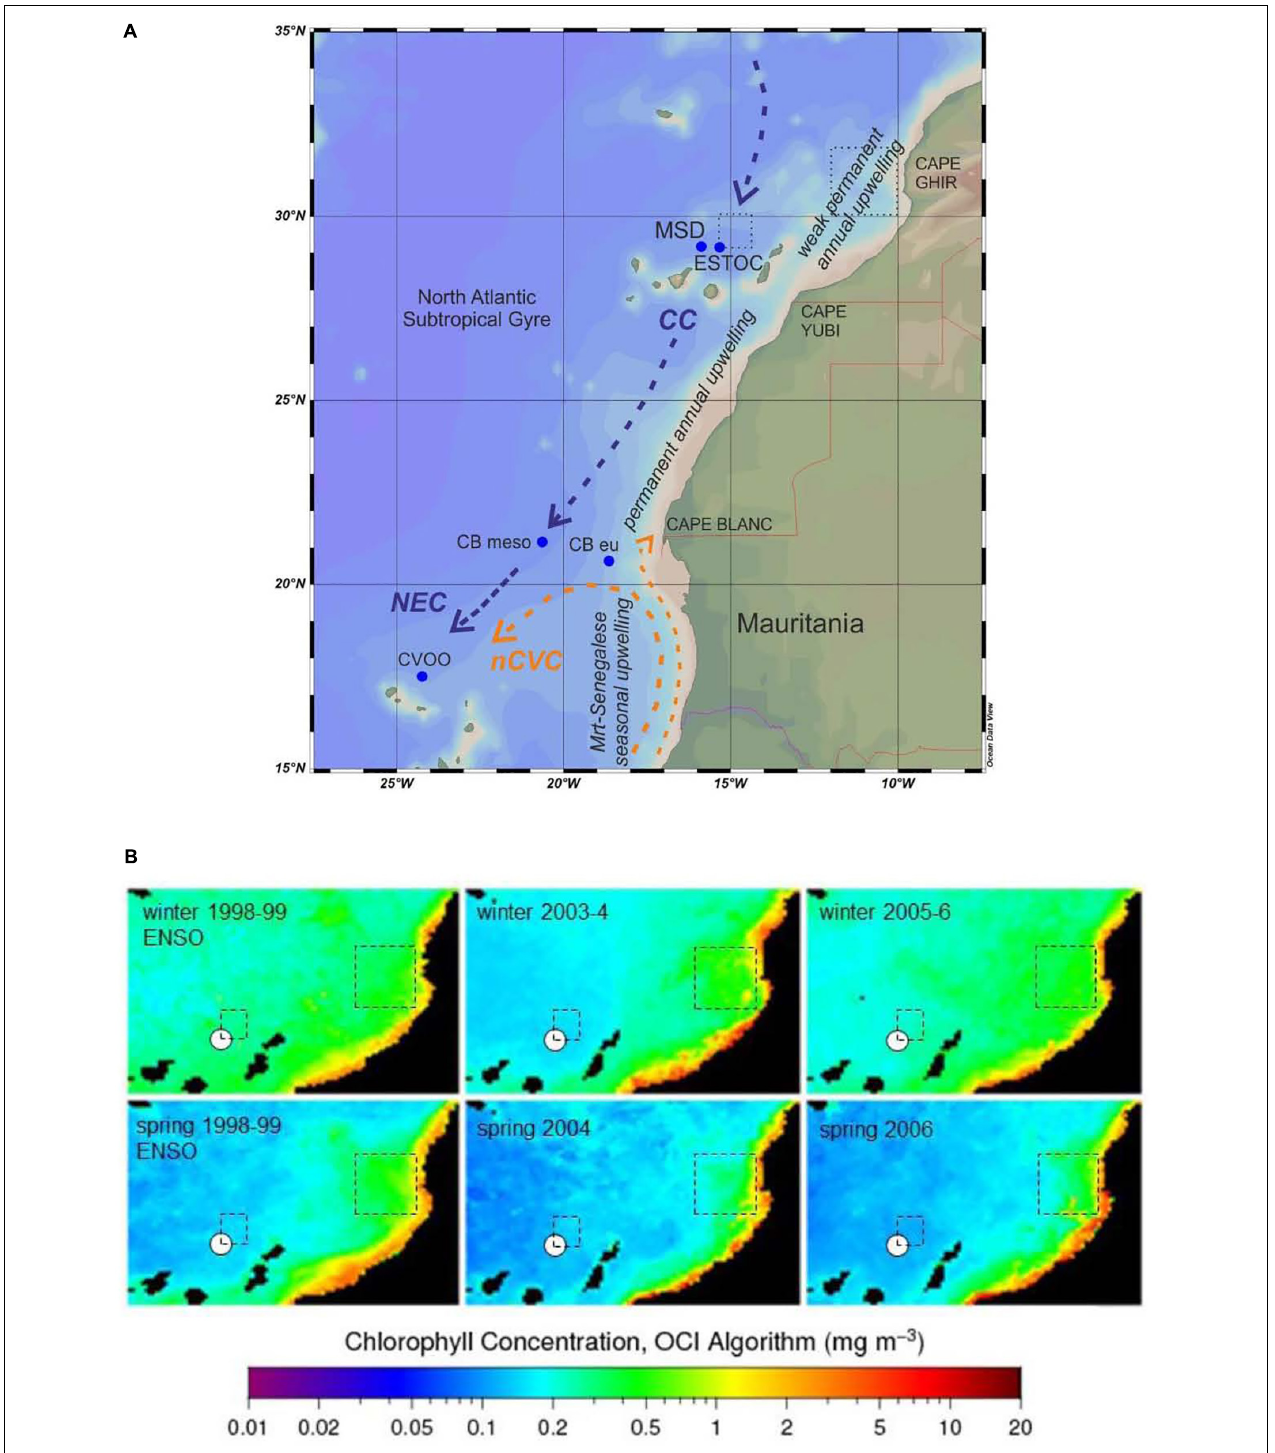
FIGURE 1 | (A) Location of ESTOC and MSD traps in the Canary Basin and other relevant time series flux sites [Cape Blanc (CBmeso, CBeu), CVOO (Cape Verde Ocean Observatory, GEOMAR)] within the Canary Current system. General currents and the upwelling zones defined by Cropper et al. (2014) are indicated. Boxes at ESTOC and Cape Ghir where environmental data have been extracted from GIOVANNI are shown as well (stippled lines). CC, Canary Current; NEC, North Equatorial Current; nCVC, northern Cape Verde Current; the northward moving coastal current is the Mauritanian Current. (B) Examples of winter and spring surface chlorophyll from SeaWiFs and MODIS (9 km resolution) for the extreme ENSO year 1999 (La Niña phase), the years 2004 and 2006 (as examples for the years before and after 2005). The ESTOC study site is marked with a white dot, the ESTOC and Cape Ghir boxes are shown.